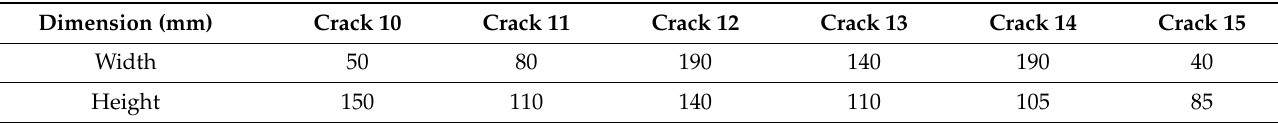
Table 3. The physical dimensions of cracks in the unseen dataset.